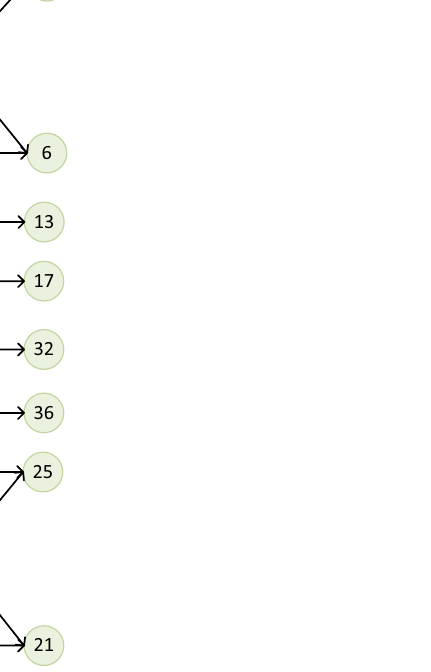
Figure 11. Precedence graph of the